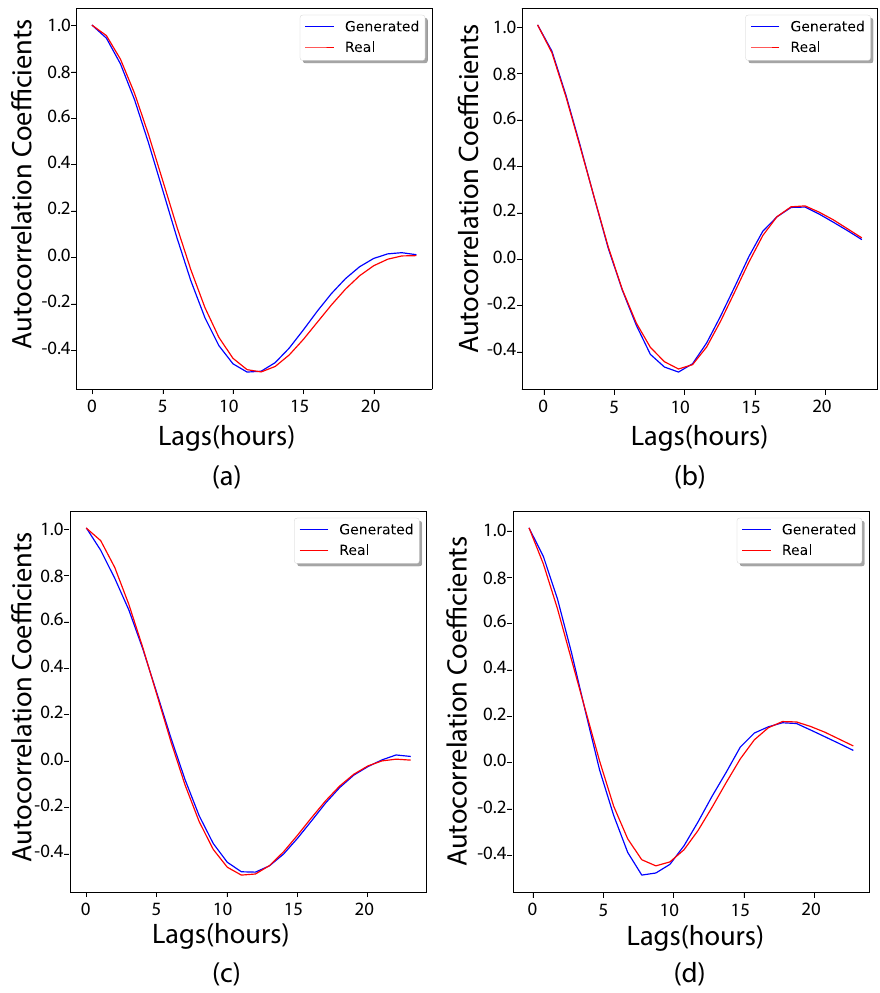
Figure 7. Summer season ACF for: ( a ) normal load; ( b ) normal solar; ( c ) abnormal load; ( d ) abnormal solar for generated and real